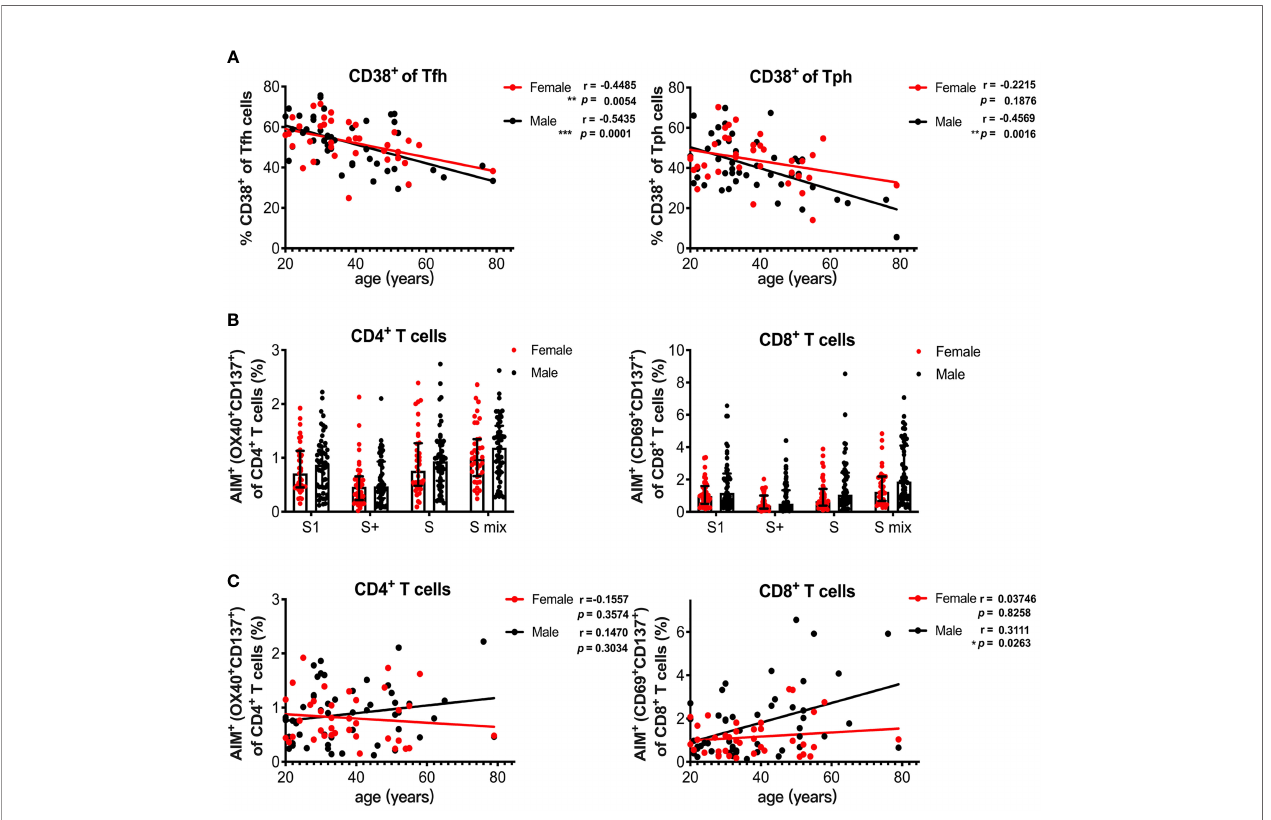
FIGURE 5 | Age and sex in fl uence T and B cell responses elicited by SARS-CoV-2 mRNA vaccination. (A) Correlation of age with CD38 + Tfh and CD38 + Tph cells. (B) Comparison of SARS-CoV-2 peptide pool-reactive AIM + CD4 + T cells and AIM + CD8 + T cells between female and male individuals at 1 month after vaccination. (C) Correlation of age with S1 peptide pool-reactive AIM + CD4 + T cells and AIM + CD8 + T cells in male and female groups. Each dot indicates the value of one individual. The box indicates the median and the whiskers indicate the fi rst and third quartiles (B) . Correlations were analyzed using Spearman ’ s correlation test (A, C) . *p < 0.05, *p < 0.01, ***p <